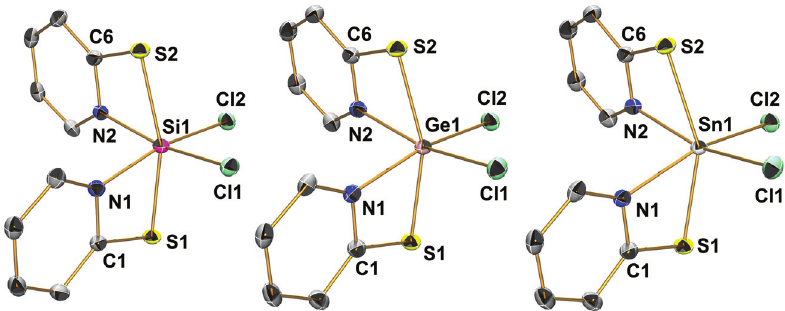
E(PyS) (E = Si, Ge, Sn) in their crystal structures. Figure 1 Molecular structures of Cl 2 2 ORTEP/POV-RAY diagrams (Farrugia, 1997; Persistence of Vision Pty. Ltd. Persistence of Vision Raytracer Version 3.6 [POV-RAY 3.6], 2004) with thermal displacement ellipsoids are shown at the 30% (Si compound) and 50% (Ge and Sn compound) probability levels. Selected atoms are labeled and hydrogen atoms are omitted for